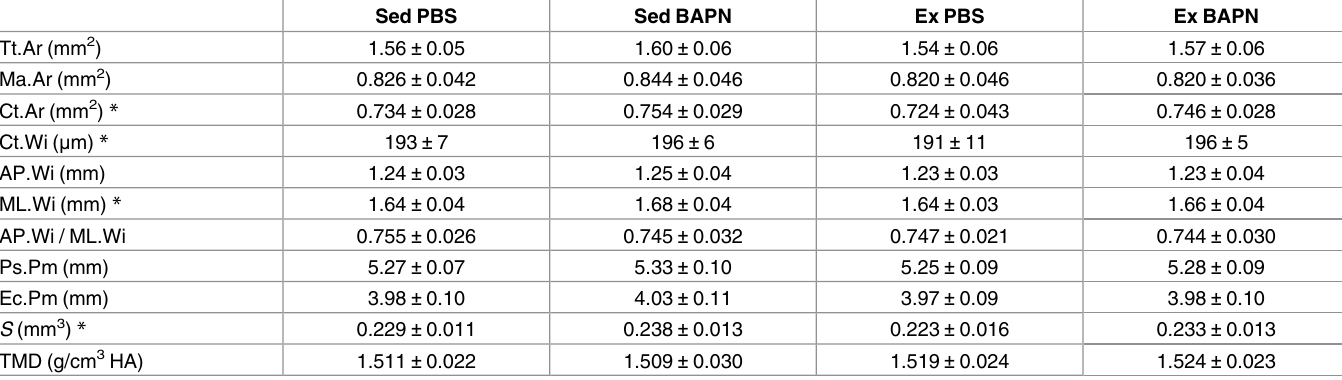
Table 3. Cortical analysis of femoral standard site.